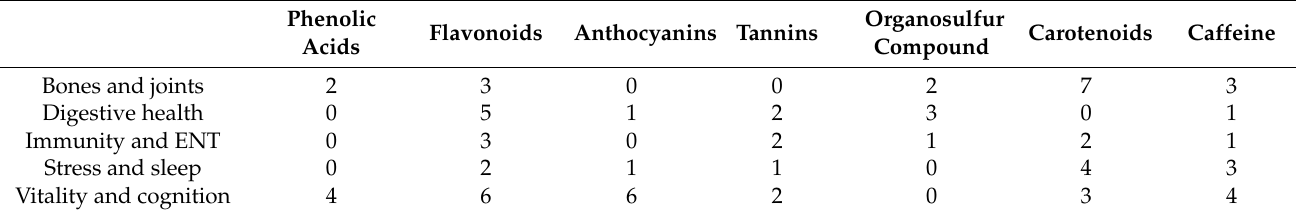
Table 2. Details of selected